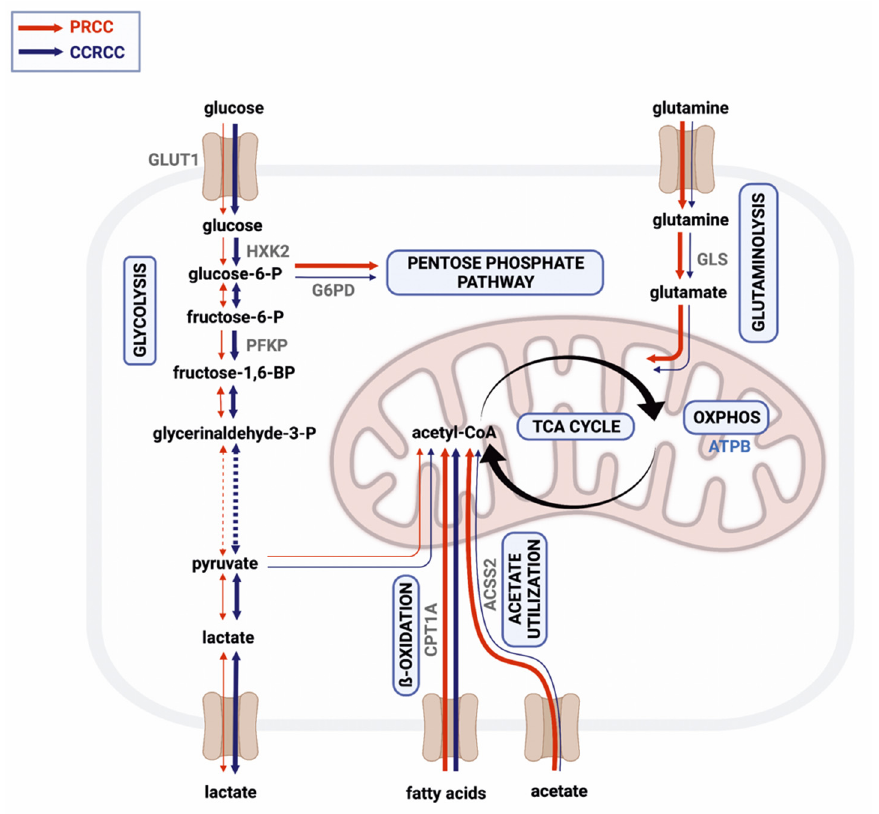
Figure 6. Simplified scheme of the metabolic pathways analyzed in papillary (PRCC) and clear cell renal cell carcinoma (CCRCC). Red and blue arrows on left and right side of black ones indicate the characteristic rewiring of metabolic pathways in PRCCs and in CCRCCs, respectively. High expressions of certain enzymes suggest balanced nutrient utilization, intensive glutaminolysis (GLS), acetate utilization (ACSS2), fatty acid oxidation (CPT1A), and oxidative phosphorylation (ATPB) were detected in PRCCs (thick red arrows), while high expressions of glycolytic enzymes (GLUT1, HXK2, PFKP) could correlate with higher glycolytic capacity in CCRCCs (thick blue arrows). Created with BioRender.com.